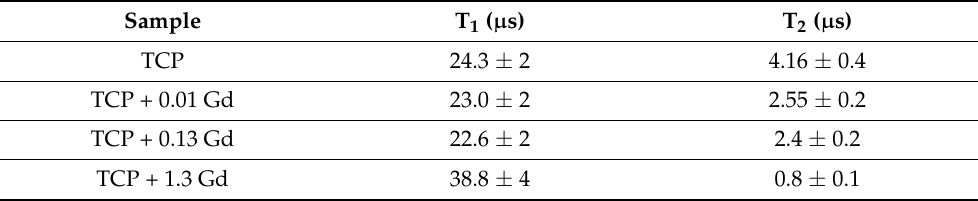
Table 4. Electron relaxation times of the nitrogen radical at T = 297 K.